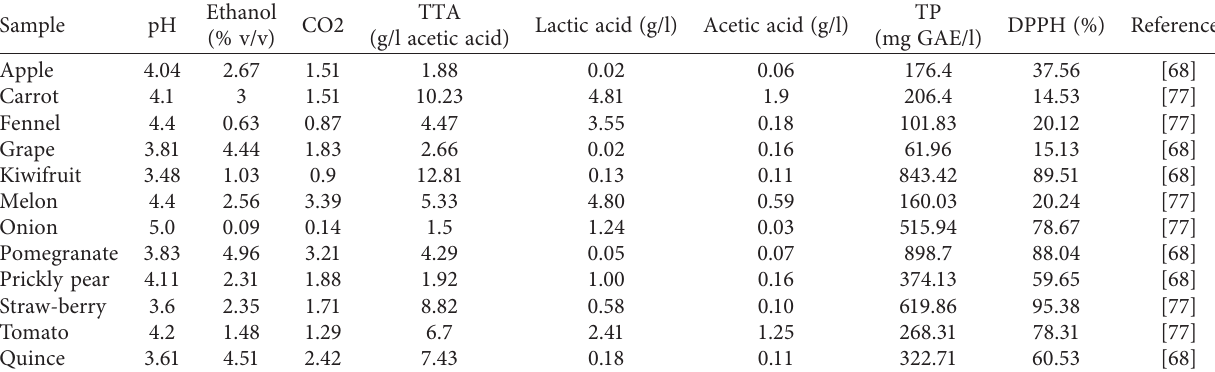
Table 4: Chemical characteristics of some fruit and vegetable juices fermented by Kefir